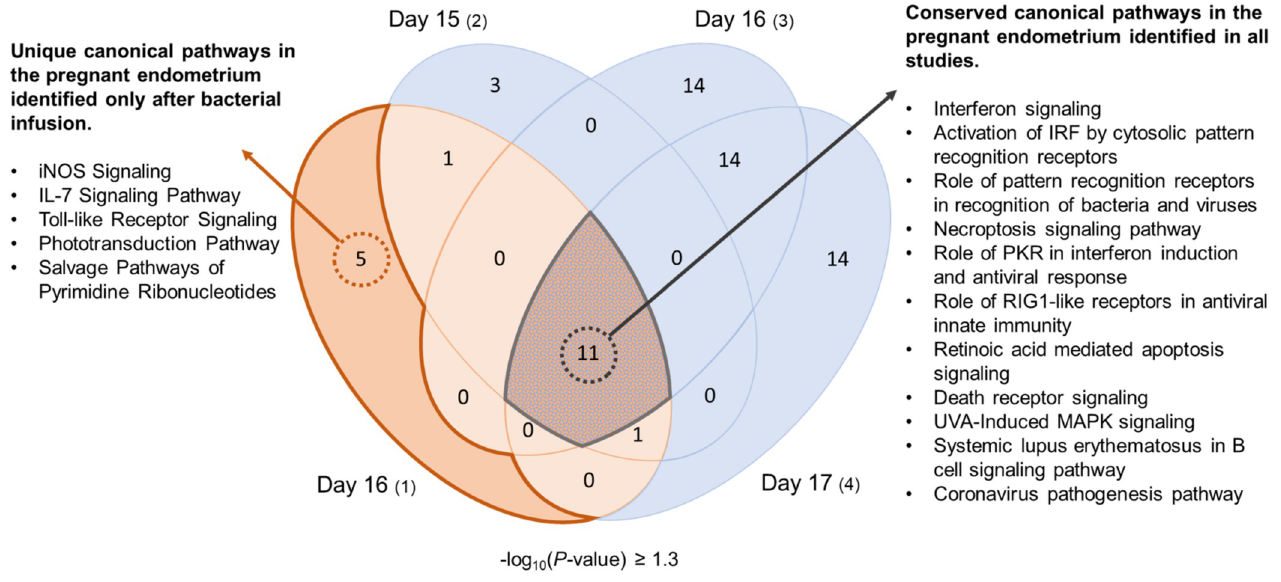
PLOS ONE | https://doi.org/10.1371/journal.pone.0265062 March 31,